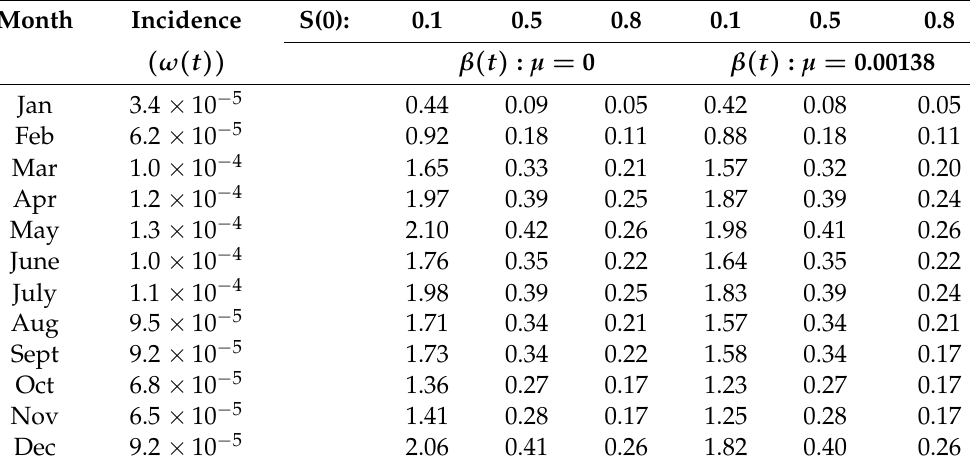
Table A2. 2005 Visceral Leishmaniasis incidence data from Bihar, India. Estimates of β ( t ) of models with and without demography.